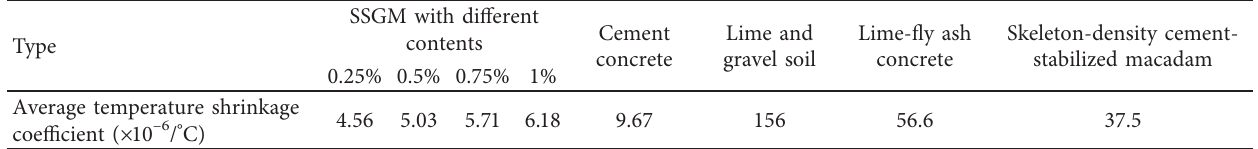
Table 4: Average temperature shrinkage coefficient of different road